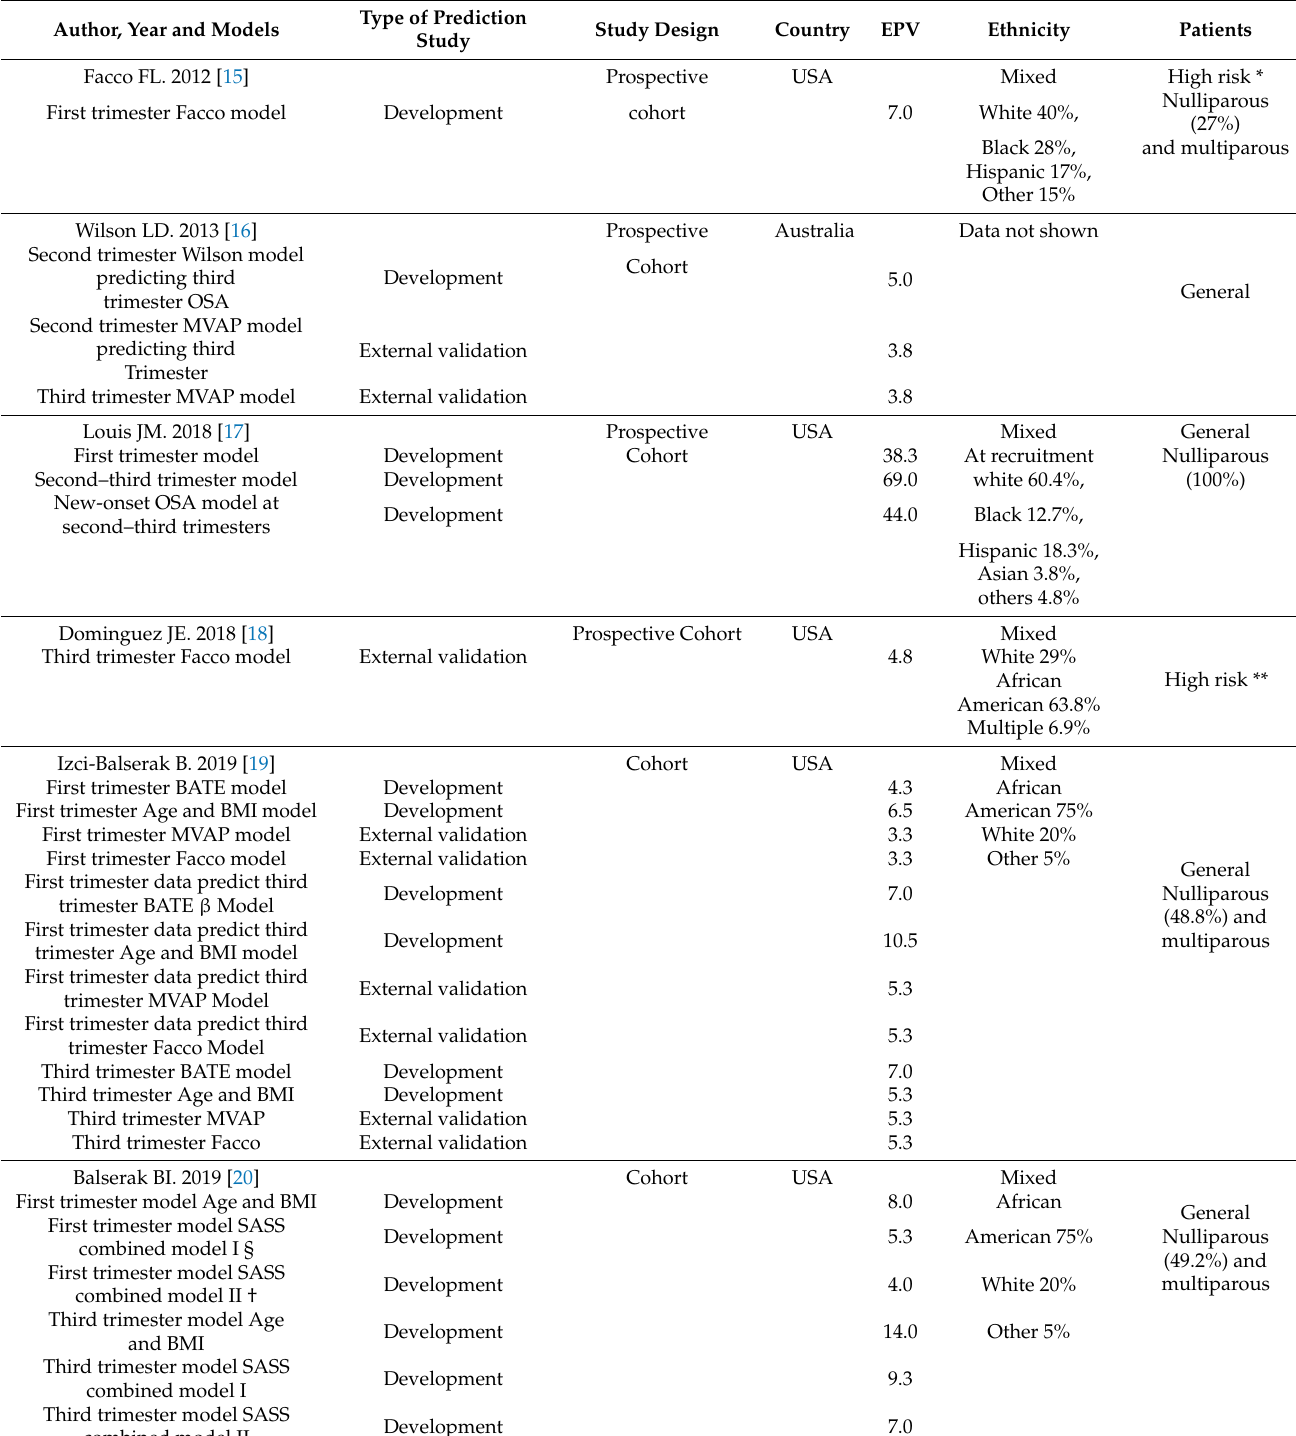
Table 1. Characteristics of prediction models for gestational obstructive sleep